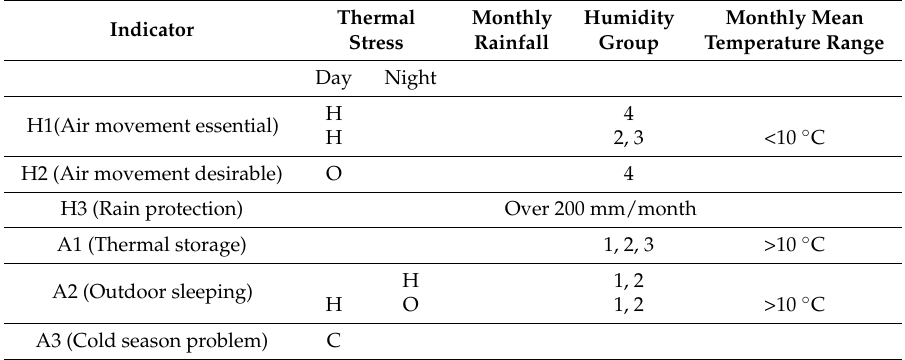
Table 10. Determination of humid and arid indicator. H, Hot; O, Comfortable; C, Cold.